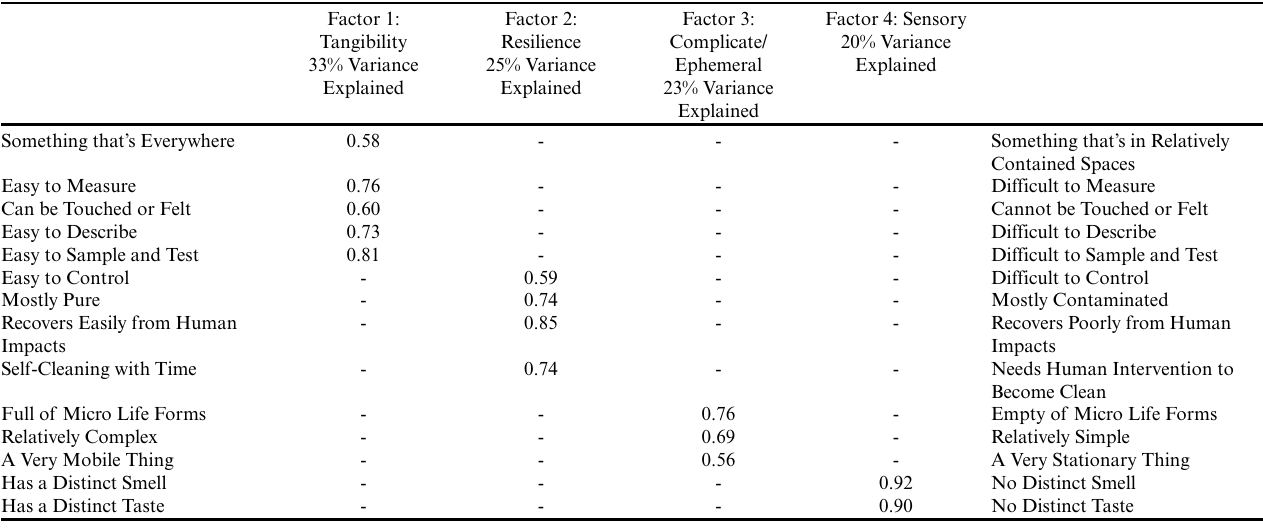
Table 4 . Principal components analysis results including factor loadings for air, water, and soil psychometric appraisals. Factor 1: Tangibility